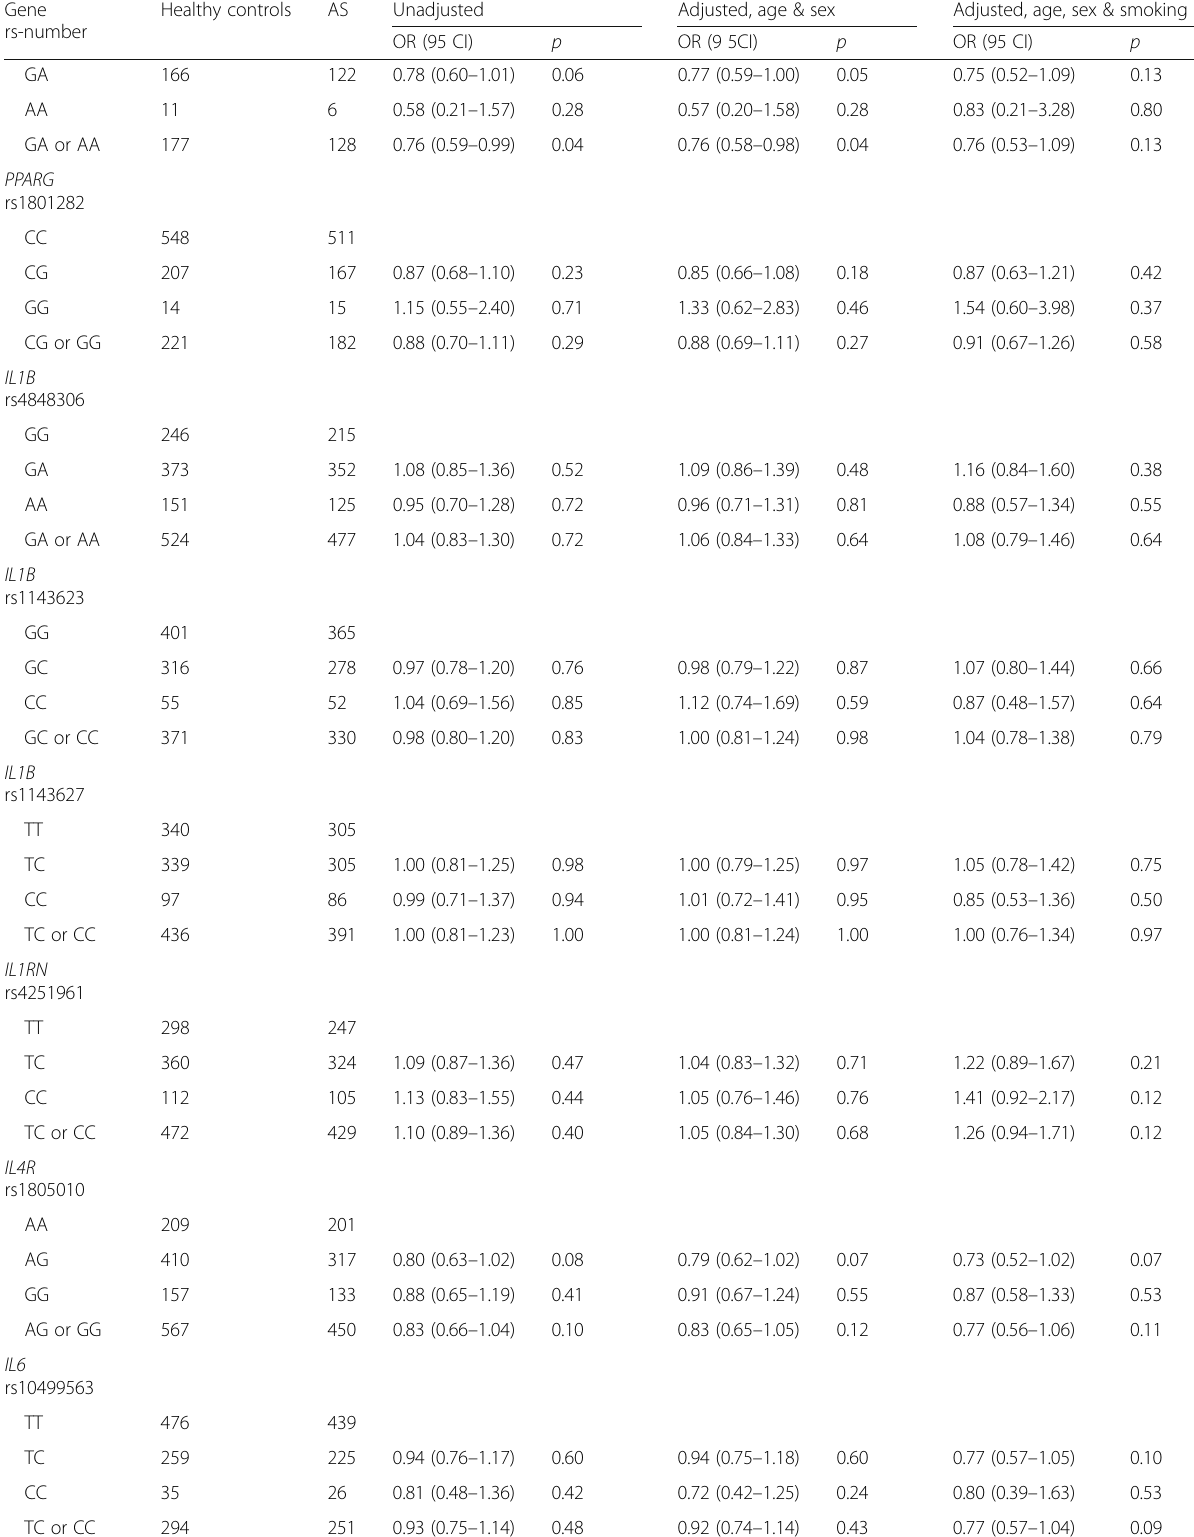
Table 1 Odds ratios (OR) and 95% confidence interval (95CI) for genotypes studied among healthy controls and patients with ankylosing spondylitis (AS)